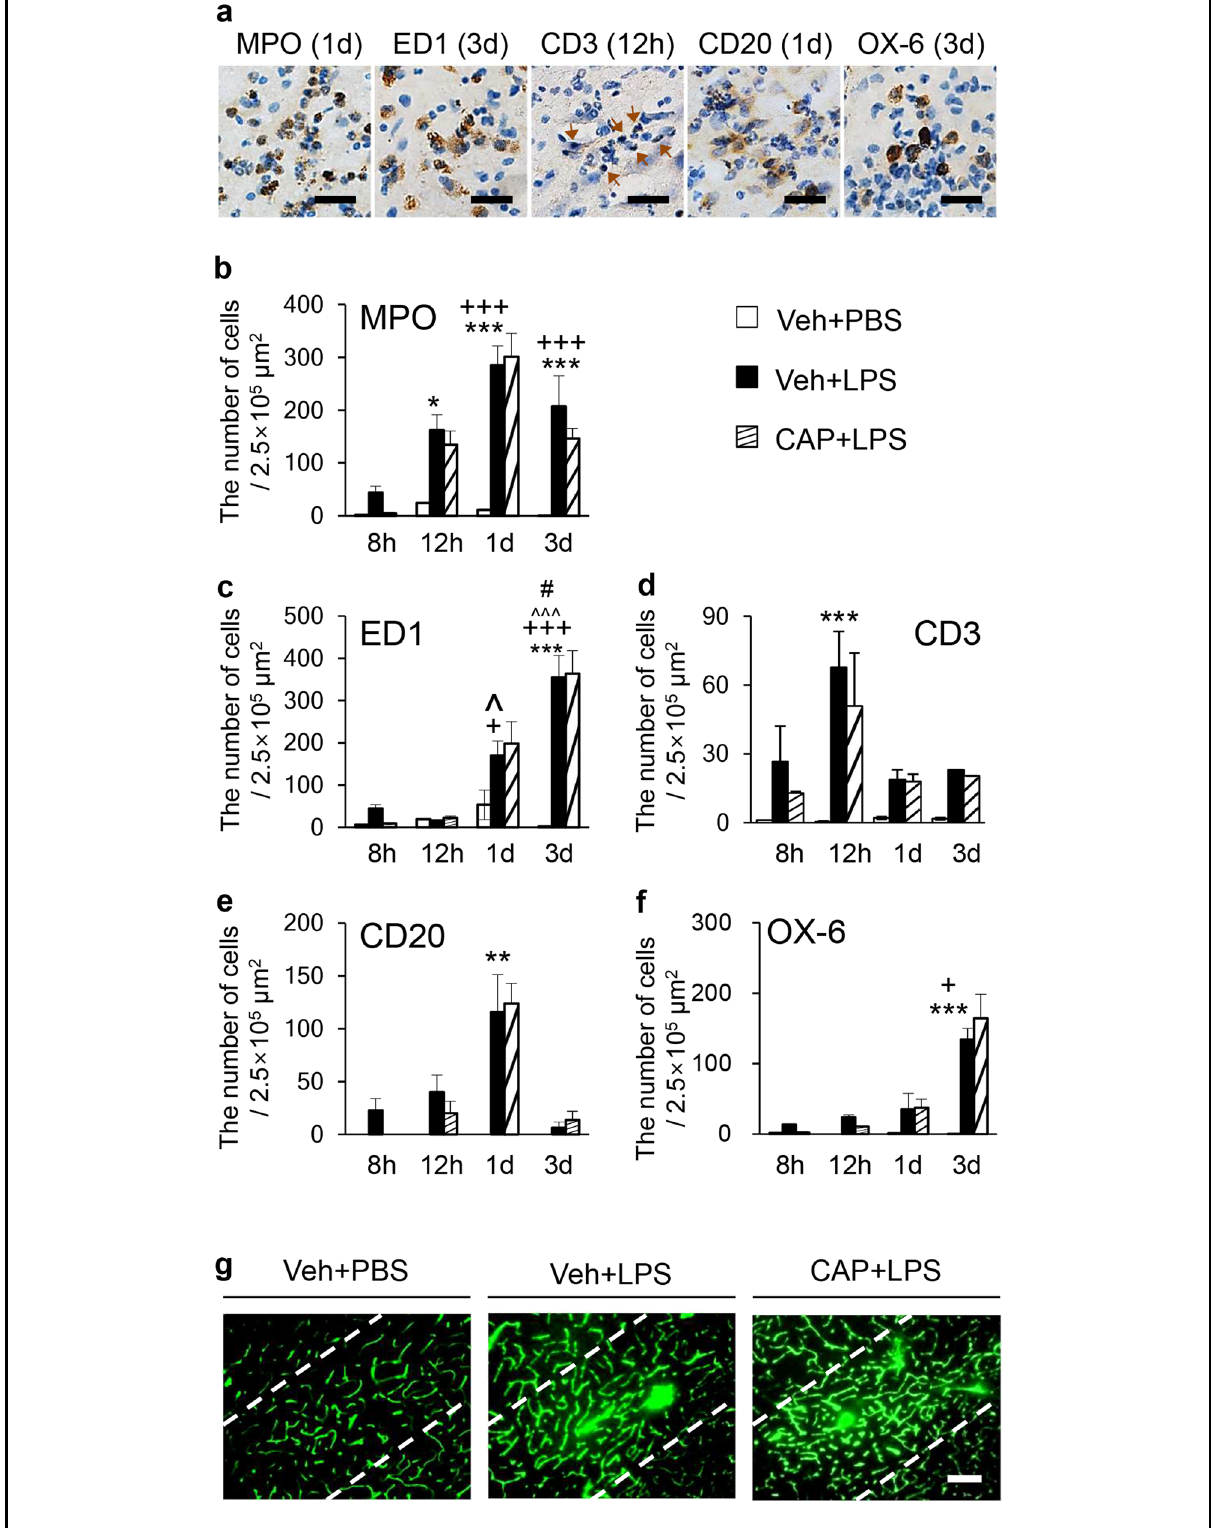
Fig. 2 (See legend on next